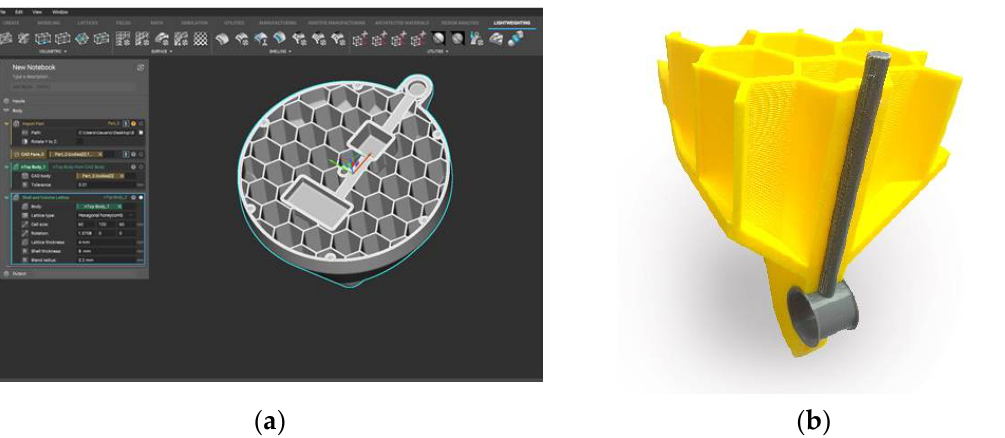
Figure 9. Sectioned views of the buoy: ( a ) Lattice design software for implicit design where the inner honeycomb structure has been done; ( b ) section of the mooring of the buoy made of PETG by fused filament fabrication (FFF).